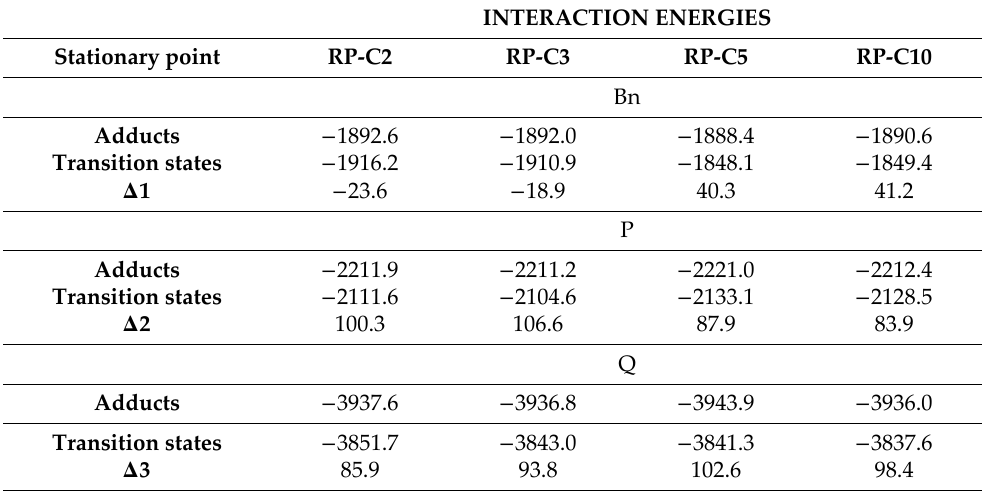
Table 3. Sum of the covalent interaction energies between atoms of the molecular fragments ℬ𝑛 and 𝒫 for all stationary points along all four potential RPs. All values are given in kcal mol − 1